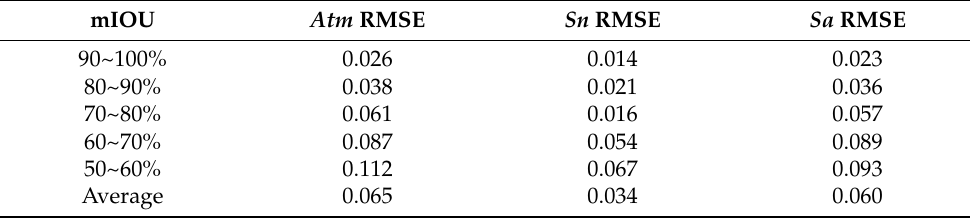
Table 6. Impact of mIOU on